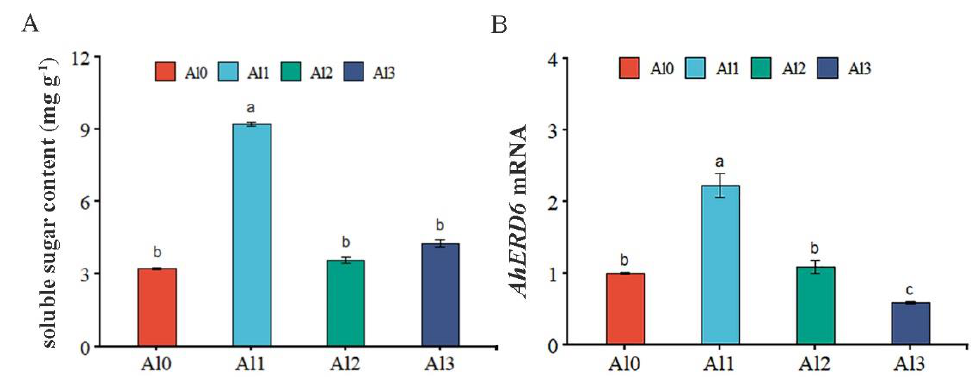
Figure 4. Effect of different Al 3+ concentrations on the soluble sugar content and AhERD6 transcript levels. The effect of Al treatments on soluble sugar content ( A ). qRT-PCR analysis of relative tran- scription levels of AhERD6 ( B ). Al0, Al1, Al2, and Al3 represent 0 (pH 6.85), 1.25 (pH 4.03), 2.5 (pH 3.85), and 5 (pH 3.69) mmol/L AlCl 3 .18H 2 O solutions, respectively. Data are means (±SE), n = 3. Marking the same letters means p ≥ 0.05 (LSD), there is no significant difference, the difference between different letters means p < 0.05 (LSD), and the difference is significant.